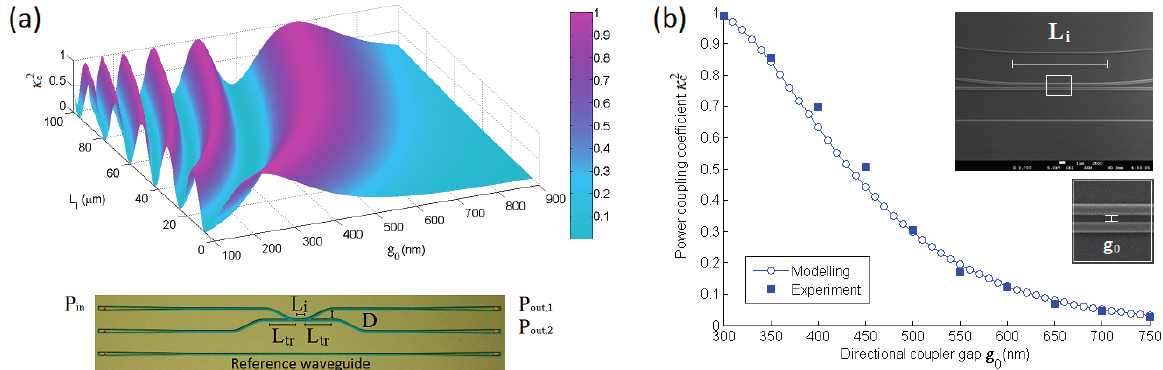
Figure 6. ( a ) 3D graph of κ (cid:3030)(cid:2870) calculated as a function of (cid:1838) S-cosine DC with the optical image of a representative S-cosine DC device ( (cid:1838) = 150 μ m, D = 50 μ m); ( b ) Power coupling coefficient, κ (cid:3030)(cid:2870) , as a function of different (cid:1838) (cid:3047)(cid:3045) gaps, g 0 , of S-cosine DCs with dimensions: (cid:1838) working at λ = 1.55 μ m; Scanning Electron Microscope (SEM) image of the coupling region with a zoom of the DC gap are also